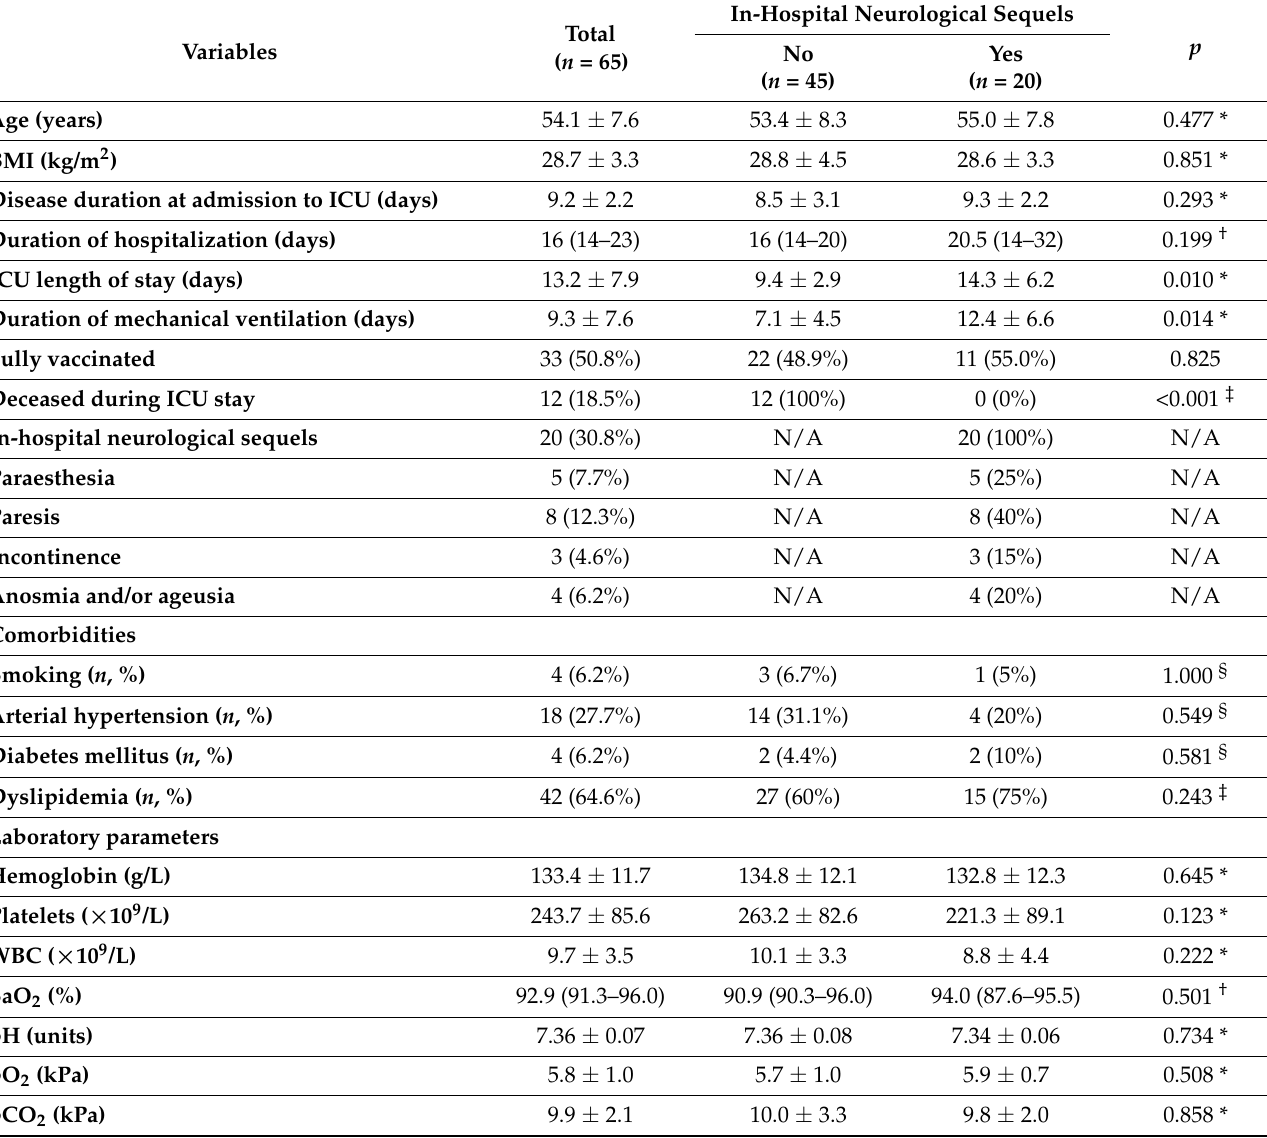
Table 1. Characteristics of patients at admission to the intensive care